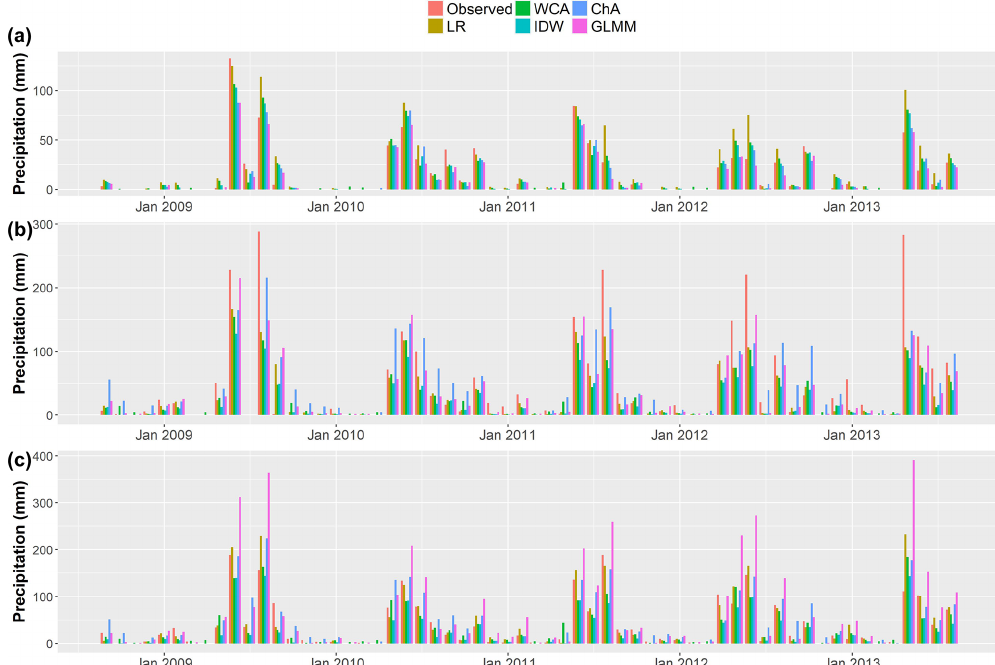
Figure 8. Validation monthly precipitation estimates for sites (a) 1 (05200007-6), (b) 27 (Lagunitas) and (c) 17 (Los Bronces).